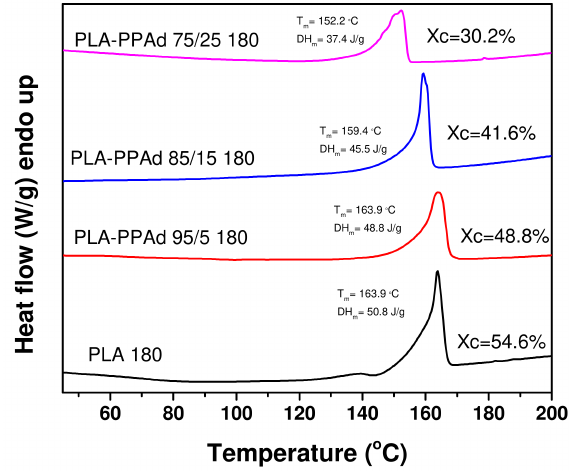
Figure 6. DSC curves of the materials prepared at 180 ◦ C after cold crystallization at 85 ◦ C for 1 h. X-ray diffraction patterns of the materials as-received from the extruder and of PPAd are presented in Figure 7a. PPAd has several crystalline reflections, typical for aliphatic polyesters with an odd number of methylene groups, at 16.8. 18.7, 20.8, 22 and 24 ◦ , which agree with previous reports [33,58,59]. Its crystal structure hasn’t been identified so far. PLA showed two strong reflections at 15.1 and 16.7 ◦ , which correspond to the (010) and (200/110) crystal planes. Its unit cell is orthorhombic [60]. After annealing (Figure 7b), PLA showed an additional strong reflection at 19 ◦ of the plane (203). The copolymers were received quite amorphous, witnessed by the large halo in the patterns, and after annealing they show the same reflection peaks as PLA. No strong peaks of PPAd can be detected, which implies that crystals of PPAd were not formed, since it crystallized in temperatures lower than room temperature. In a previous study, it was found that PPAd blocks were not able to crystallize in copolymers with PCL [57].